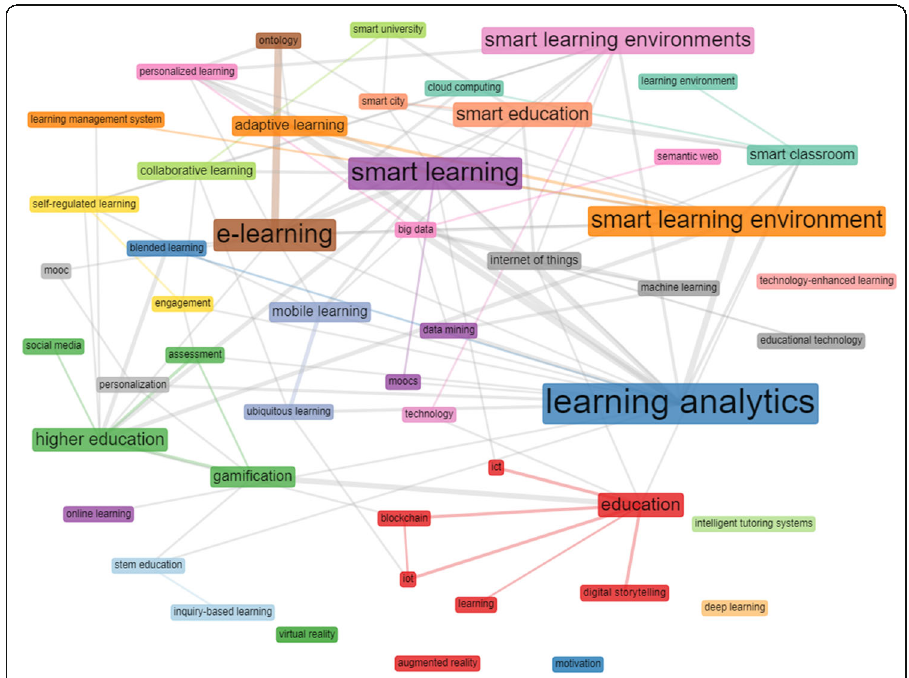
Fig. 10 Co-occurrence network of keywords: the thicker line indicates a strong association between those keywords; thinner lines depict weak association, and keywords without connecting lines indicate that no relationship has been